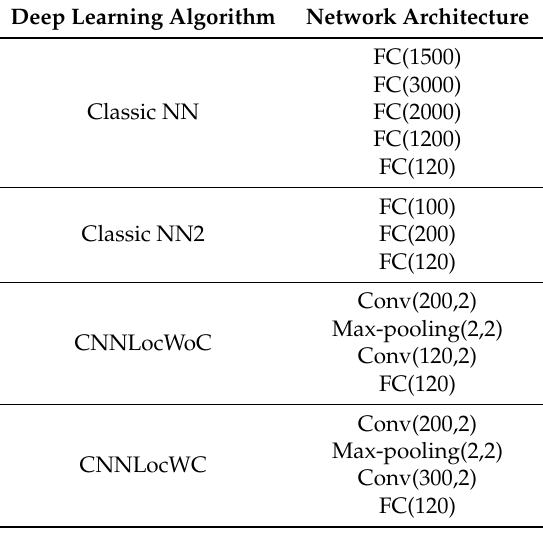
Table 10. The deep learning network architectures